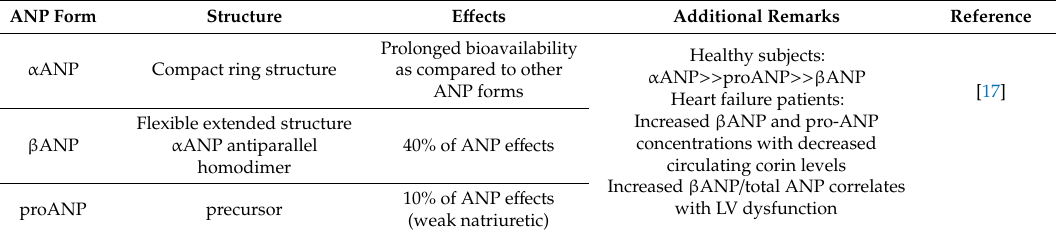
Table 1. Various forms of atrial natriuretic peptide. ANP- atrial natriuretic peptide; LV- left ventricle. ANP Form Structure E ff ects Additional Remarks